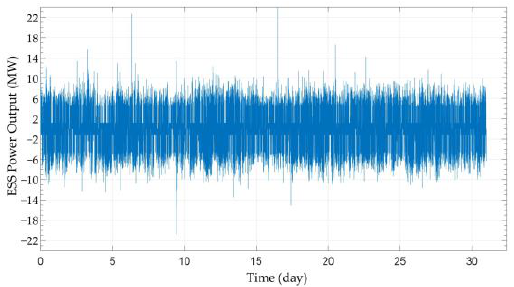
Figure 4. ESS power output according to the change in frequency. Figure 5 indicates the operation efficiency and distribution derived from the operation data for one week. The efficiency data was measured at a lithium battery energy storage system installed